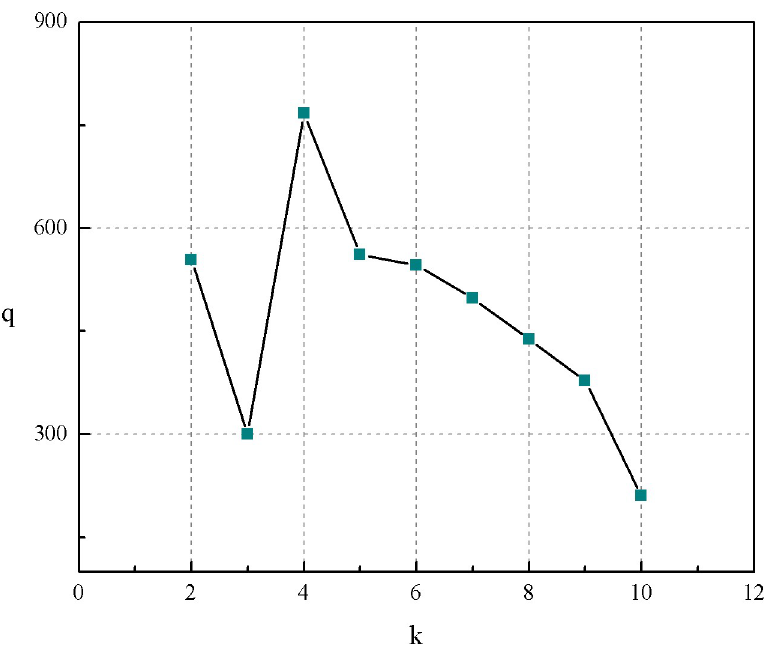
Fig 2. Selection of the best k